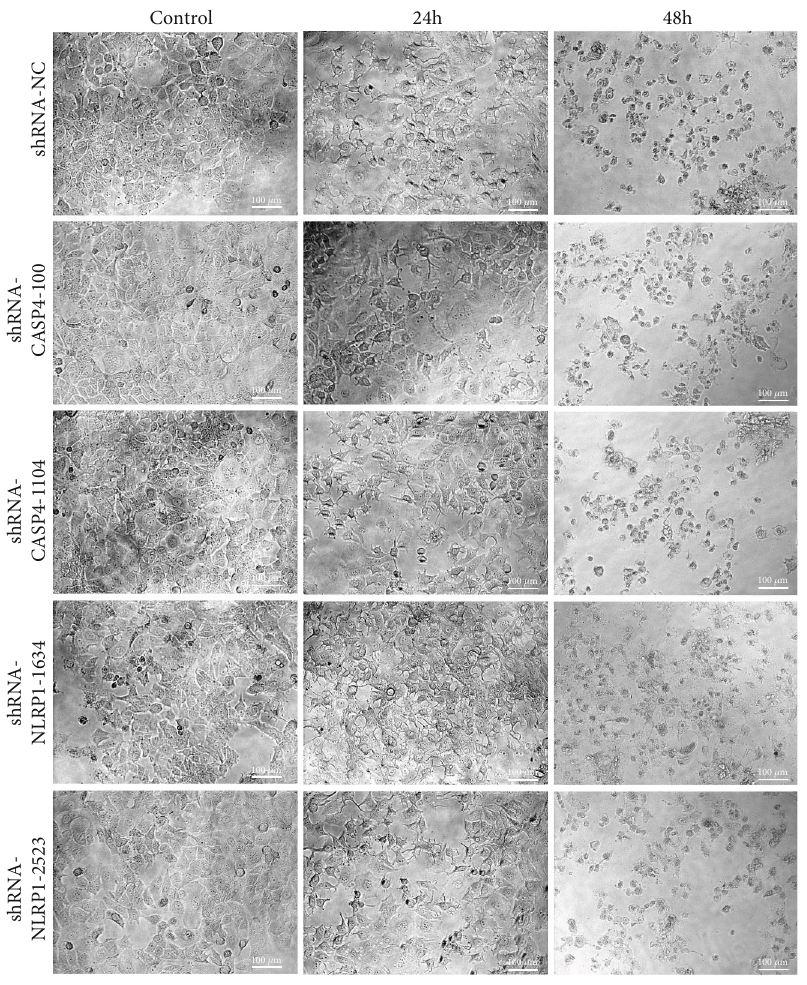
Figure 3: Morphological changes in transfected MCF7 cells exposed to hUCMSC-CM. Images were obtained on 24h and 48h. Representative micrographs from at least three independent experiments are shown. All images were taken using 20x magni fi